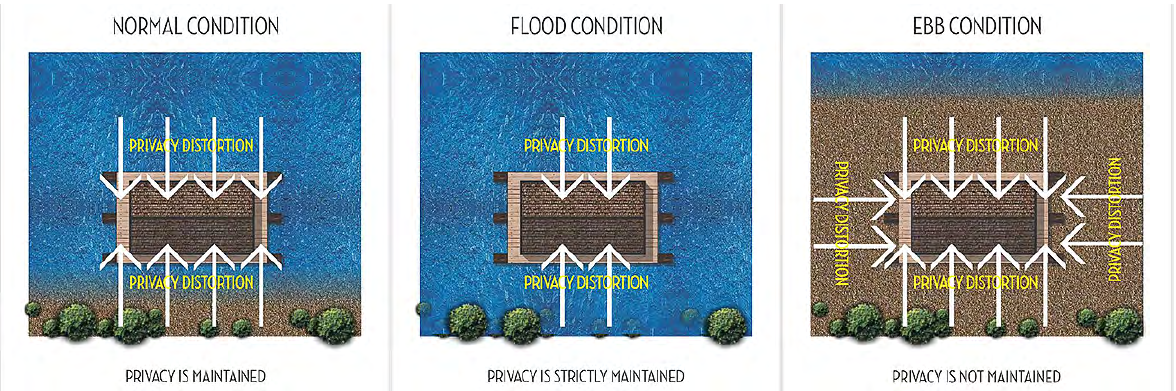
Figure 14. Territory modification in floating house